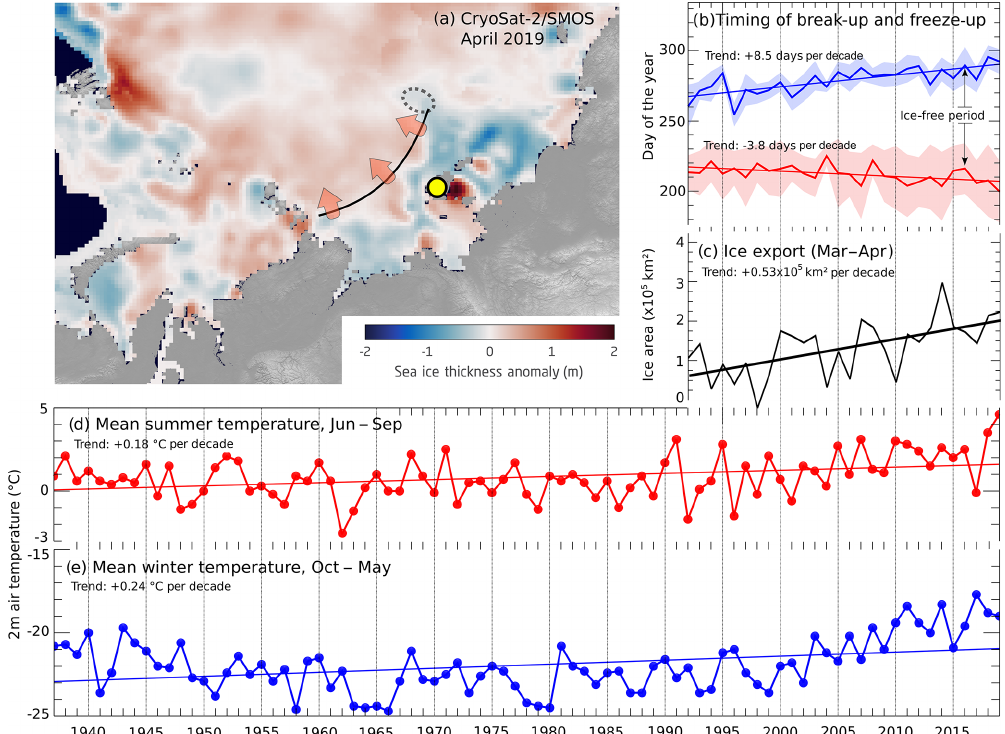
Figure 2. Summary of various processes that affected ice formation in the Laptev Sea and the East Siberian Sea in winter 2018/2019: (a) CryoSat-2–SMOS sea ice thickness anomaly at the end of the winter (April 2019 minus April 2010–2018) in the eastern Eurasian Arctic. A zone of thinner ice was present prior to the onset of melting along the coastline. The ice field in which the MOSAiC expedition was set up 5 months later is marked by a dotted line. (b) Estimate of the onset of break-up (red line) and freeze-up (blue line) with their standard deviations and trends between 86 ◦ N, 100 ◦ E and 71 ◦ N, 160 ◦ E. (c) Satellite-based late winter (March–April) ice area export through a “gate” spanning from 110 to 160 ◦ E at 77.5 ◦ N. A trend line is plotted on top. In (a) , the gate is depicted as a solid black line. (d, e) Air temperatures (2m) recorded at Kotelny meteorological station (yellow circle in a ) between 1935 and 2019 in the summer (red line) and winter months (blue line). All trends provided in this graph are significant at a 95% confidence